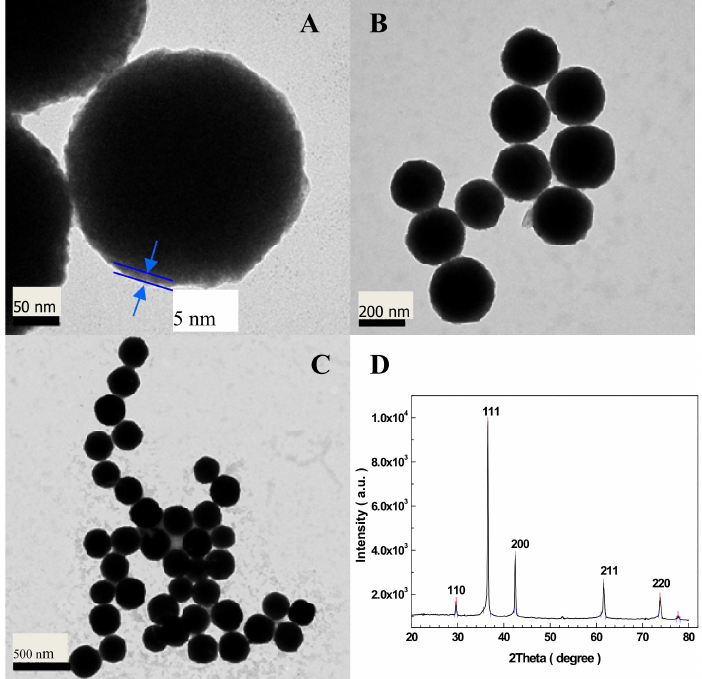
Figure 1. TEM images ( A – C ) and XRD pattern ( D ) of Cu 2 O–BSA NPs. The red lines in D are the standard peaks (PDF No. 65-3288) of Cu 2